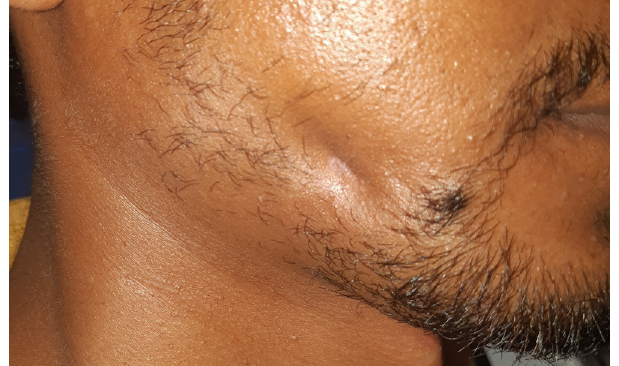
Fig. 5. Completely healed sinuses.